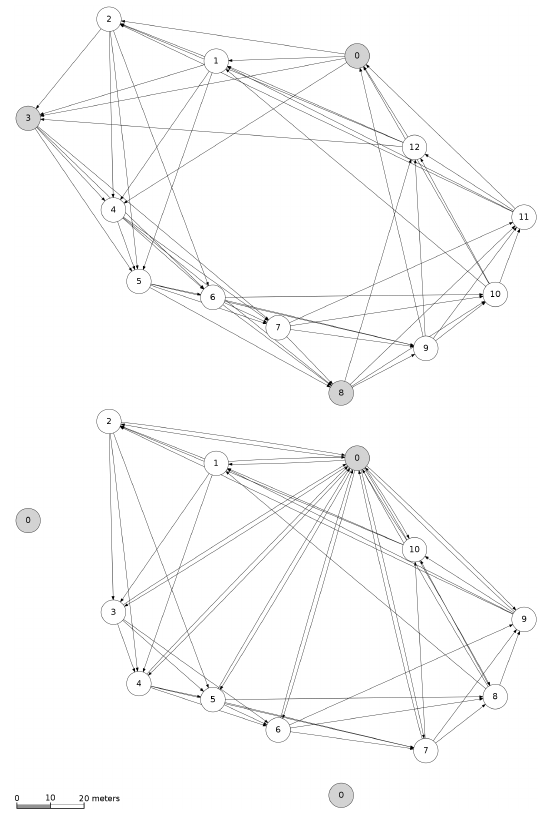
Figure 3. Above: A typical directed graph for a SLAM problem. Each node is connected to a few further nodes that can be matched to it and the loop is closed. The grey nodes have to be regarded as fixed. Below: Structure of the graph after the scan fixing proce- dure has been applied. The fixed scans are now treated as a single